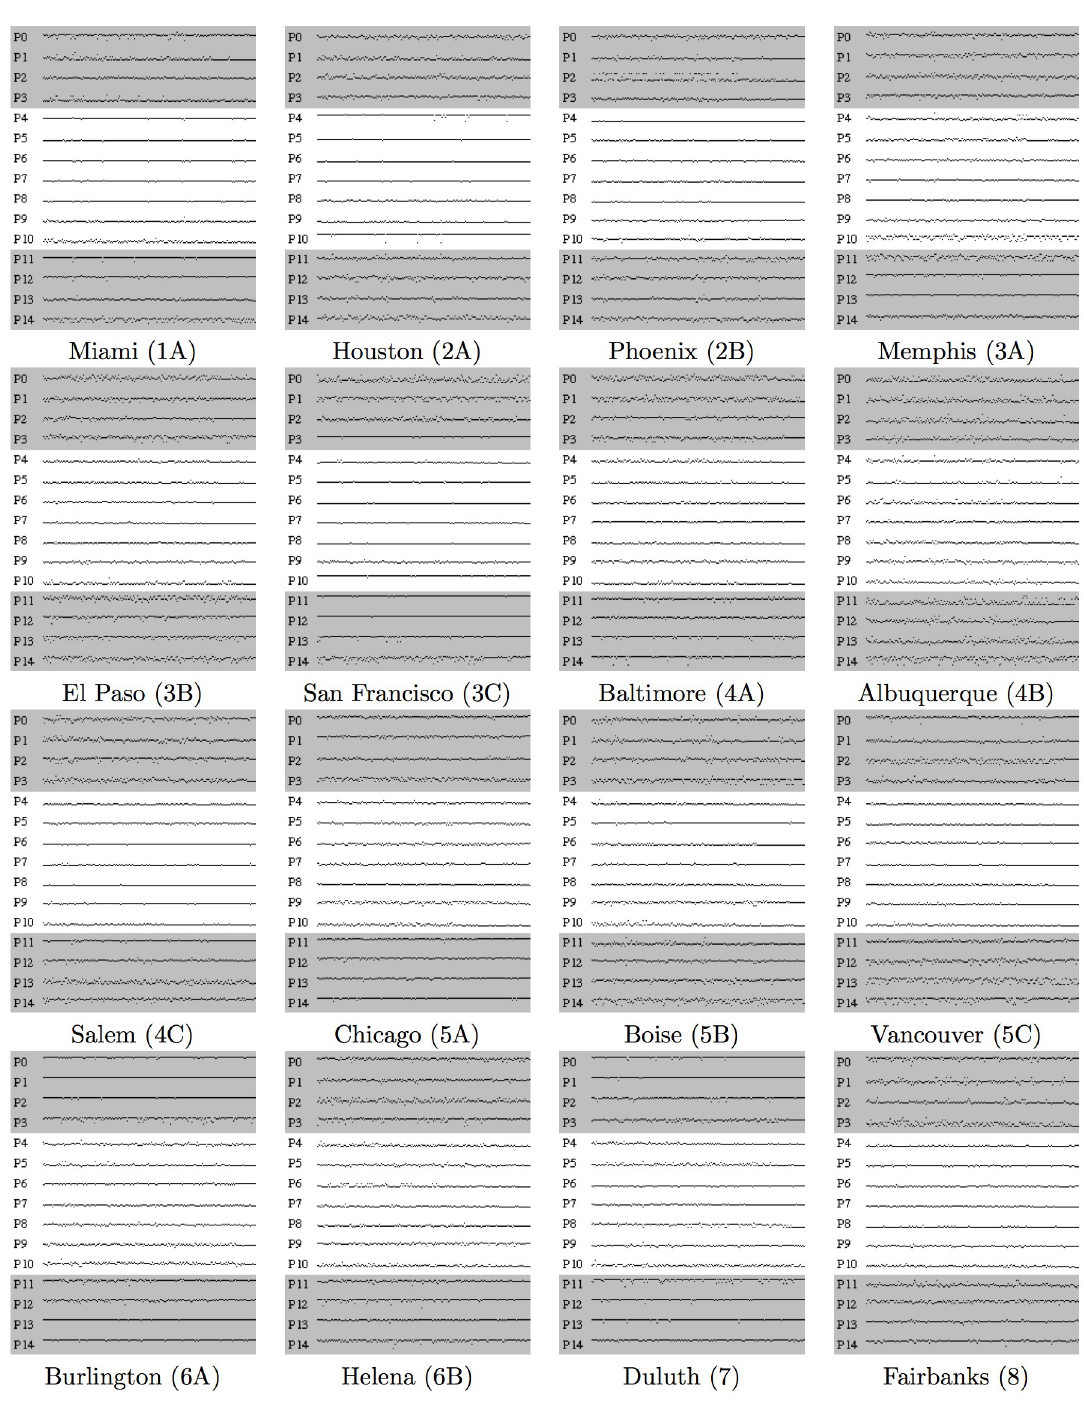
PLOS ONE | https://doi.org/10.1371/journal.pone.0203575 September 7,